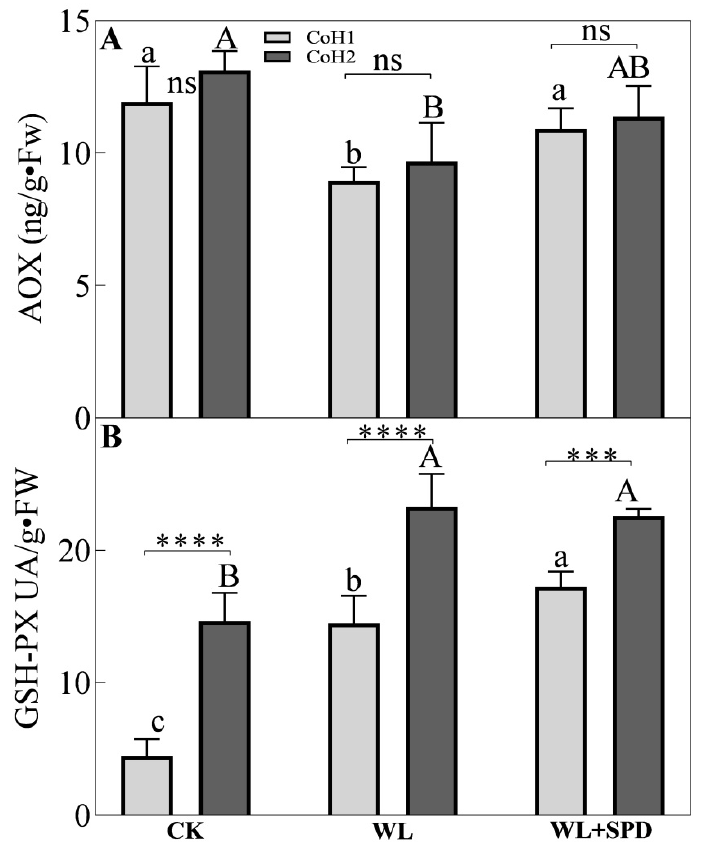
Figure 6. AOX ( A ) and GSH-PX ( B ) activities in C . oleifera under WL and exposed to SPD treatment. The bars on the top show SE (n = 5), and different lowercases and uppercases indicate significant differences among CK, WL, and WL + SPD treatments within each species according to Tukey’s multiple comparison test, respectively ( p < 0.05). The signs such as NS in the figures concern the significance difference between the same treatment for CoH1 and CoH2 (***, p < 0.0005; ****, p < 0.0001; ns , Not significant). CK: control; WL: waterlogging; SPD: spermidine.